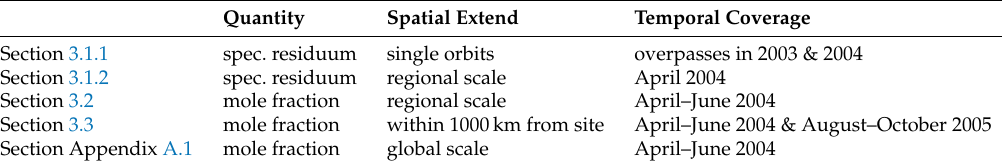
Table 2. Outline of the experiments conducted in the respective